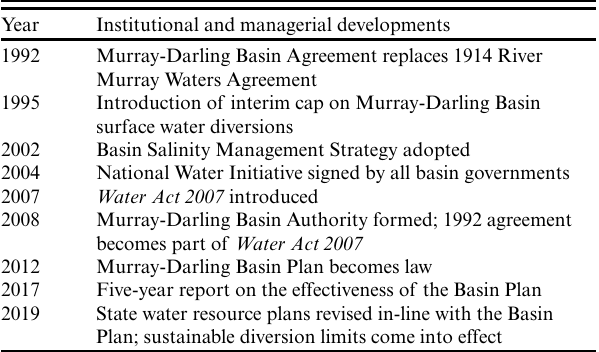
Table 1 . Institutional and management developments in the Murray-Darling Basin, 1992–2019.